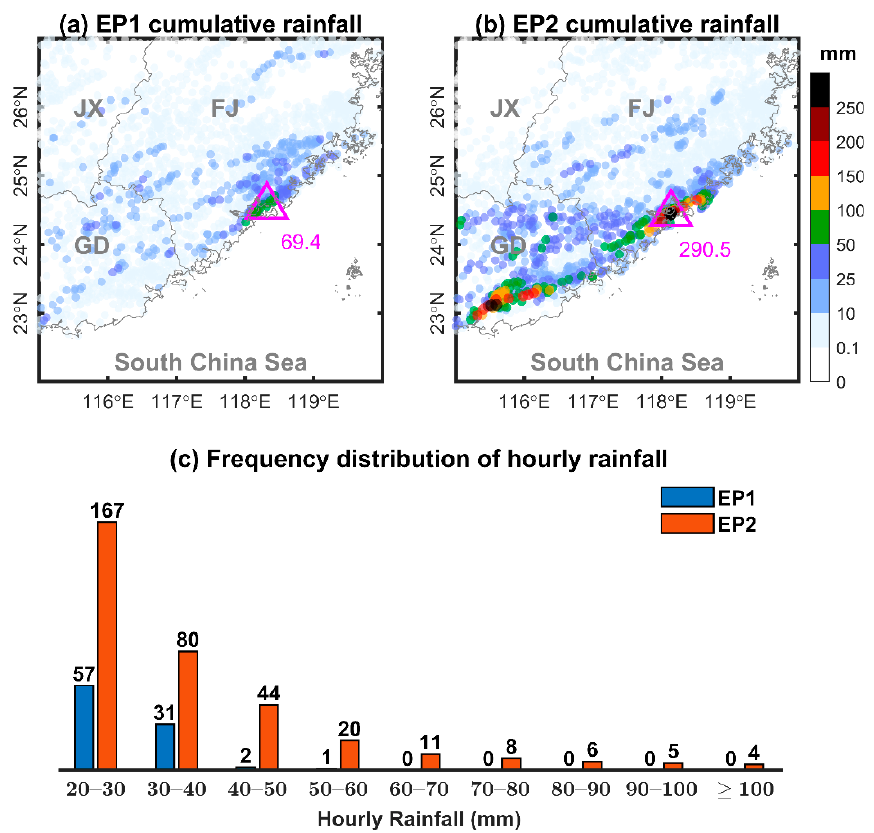
Figure 6. Cumulative rainfall of two successive warm ‐ sector rainfall episodes over southeastern China ( a ) between 0500 and 2200 LST on 6 May 2018 (EP1) and ( b ) between 0000 and 1700 LST on 7 May 2018 (EP2), along with ( c ) the frequency distribution of hourly rainfall in EP1 and EP2. The magenta triangles in ( a , b ) denote the maximum cumulative rainfall within the region. In ( a,b ), the provincial boundaries are denoted by gray curves. The frequency in ( c ) was calculated based on the hourly rainfall samples recorded by the rain gauges within southeastern China (22.5°N–26.5°N, 115°E–120°E) for each warm ‐ sector rainfall episode. For example, if there were n j rain gauges with